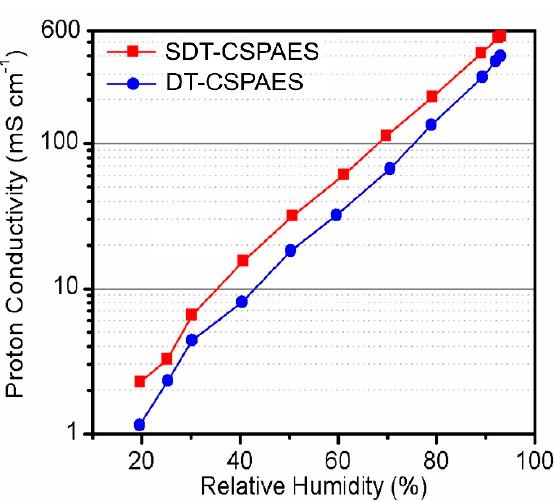
Figure 6. Proton conductivity of SDT-CSPAES and DT-CSPAES membranes at 120 °C as a function of RH.